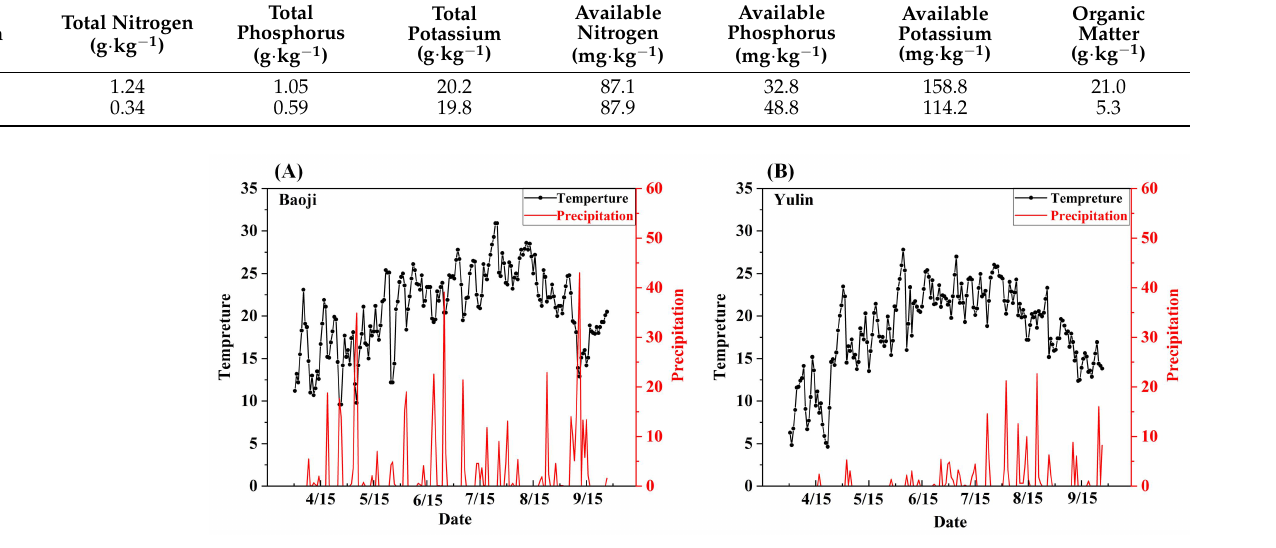
Figure 1. Daily average temperature and precipitation from April to October in Baoji ( A ) and Figure 3 Yulin ( B